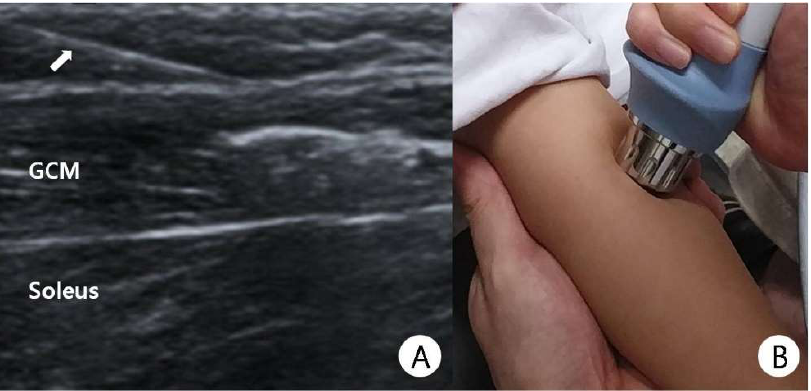
Figure 1. ( A ) Botulinum toxin A injection at the gastrocnemius (GCM) muscle under sonographic guidance (white arrow: needle). ( B ) Application of radial extracorporeal shock wave therapy (ESWT) on the GCM of an 87-month-old child with spastic cerebral